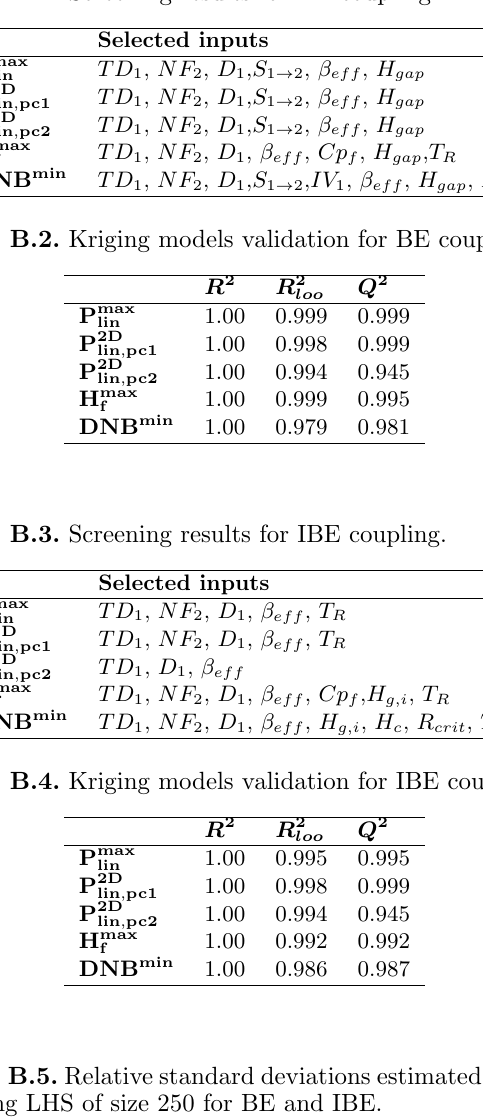
Table B.1. Screening results for BE coupling.